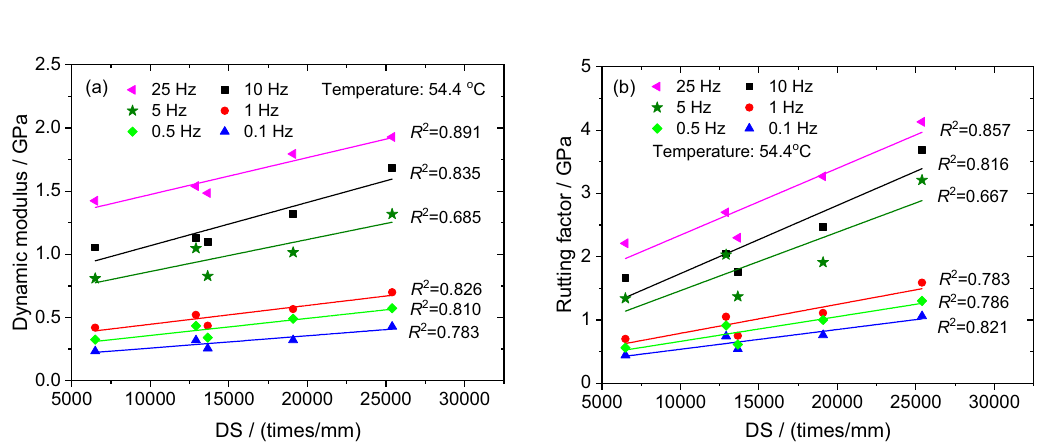
Figure 8: ( a ) Correlations between the dynamic modulus and DS and ( b ) correlations between the rutting factor and